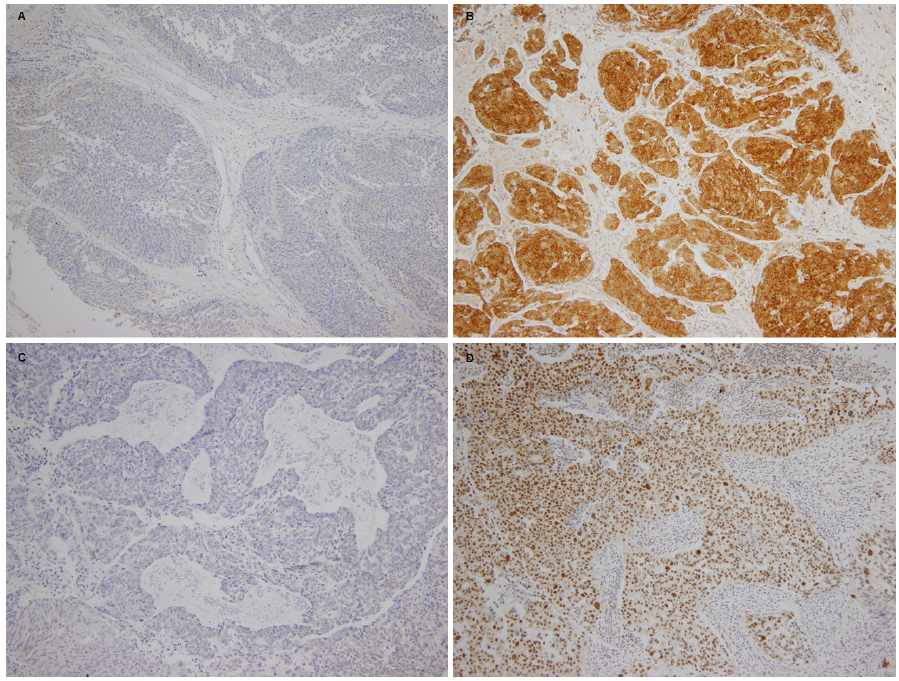
Fig 1. RRM1 and ERCC1 expression in immunohistochemistry (magnified 400×,) (A) Low expression of RRM1, (B) High expression of RRM1, (C) Low expression of ERCC1, (D) High expression of ERCC1, (original magnification, x400 in